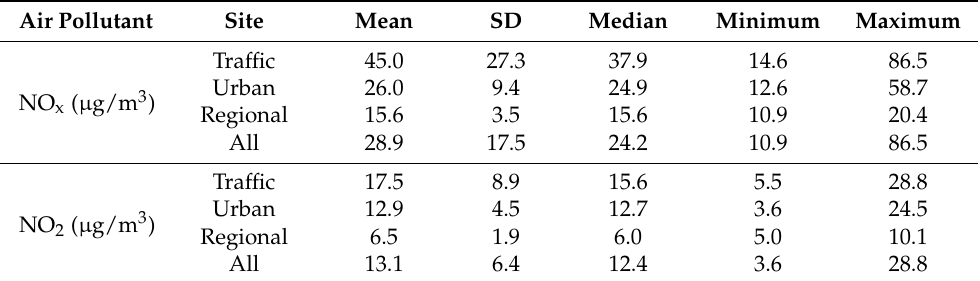
Table 2. Annual mean, standard deviation (SD), median, minimum, and maximum NO x and NO 2 concentrations for each class of measurement sites.